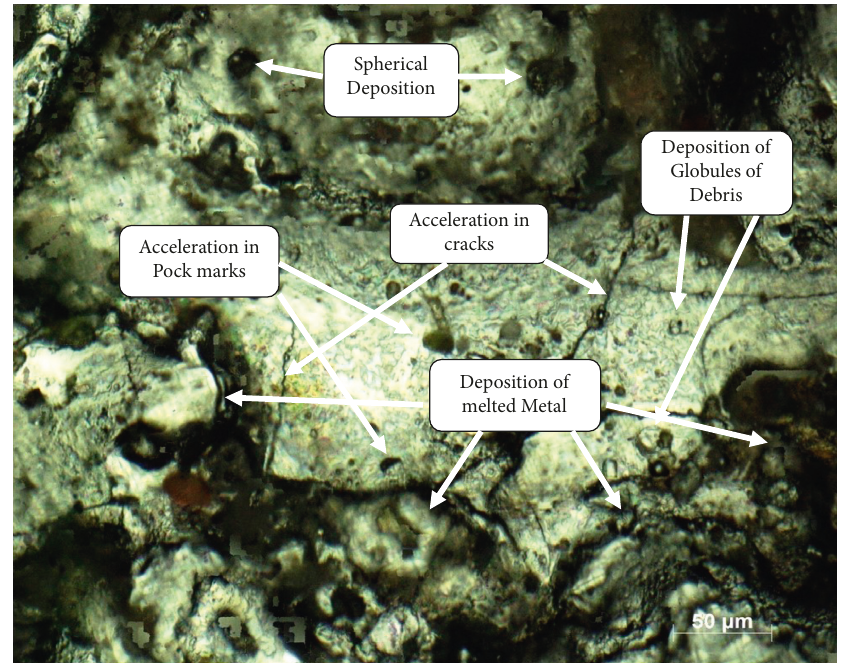
Figure 16: Analysis of surface topography for experimental run 19 using the parametric